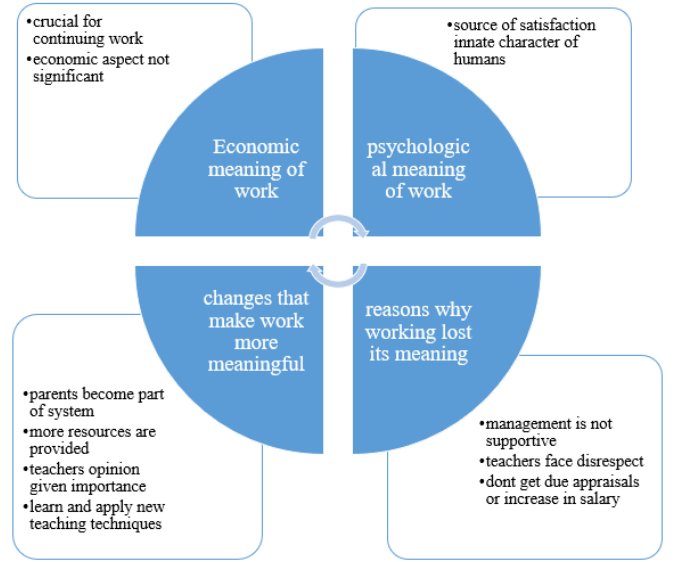
Figure 1: Thematic map meaning of